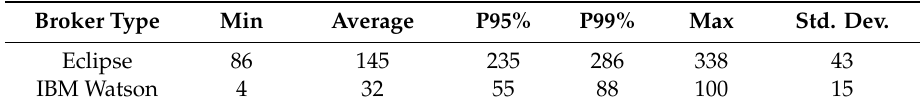
Table 1. Statistics of the D PC (Delay from Publisher to Cloud user application) collected in the experiments. All values are in